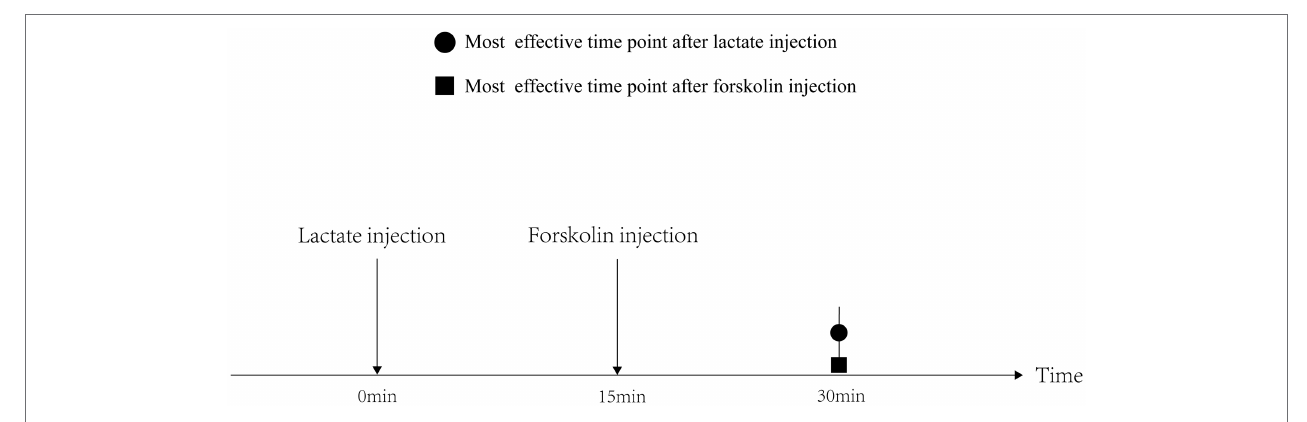
FIGURE 10 | Effectivity of lactate and forskolin injection on cAMP-PKA